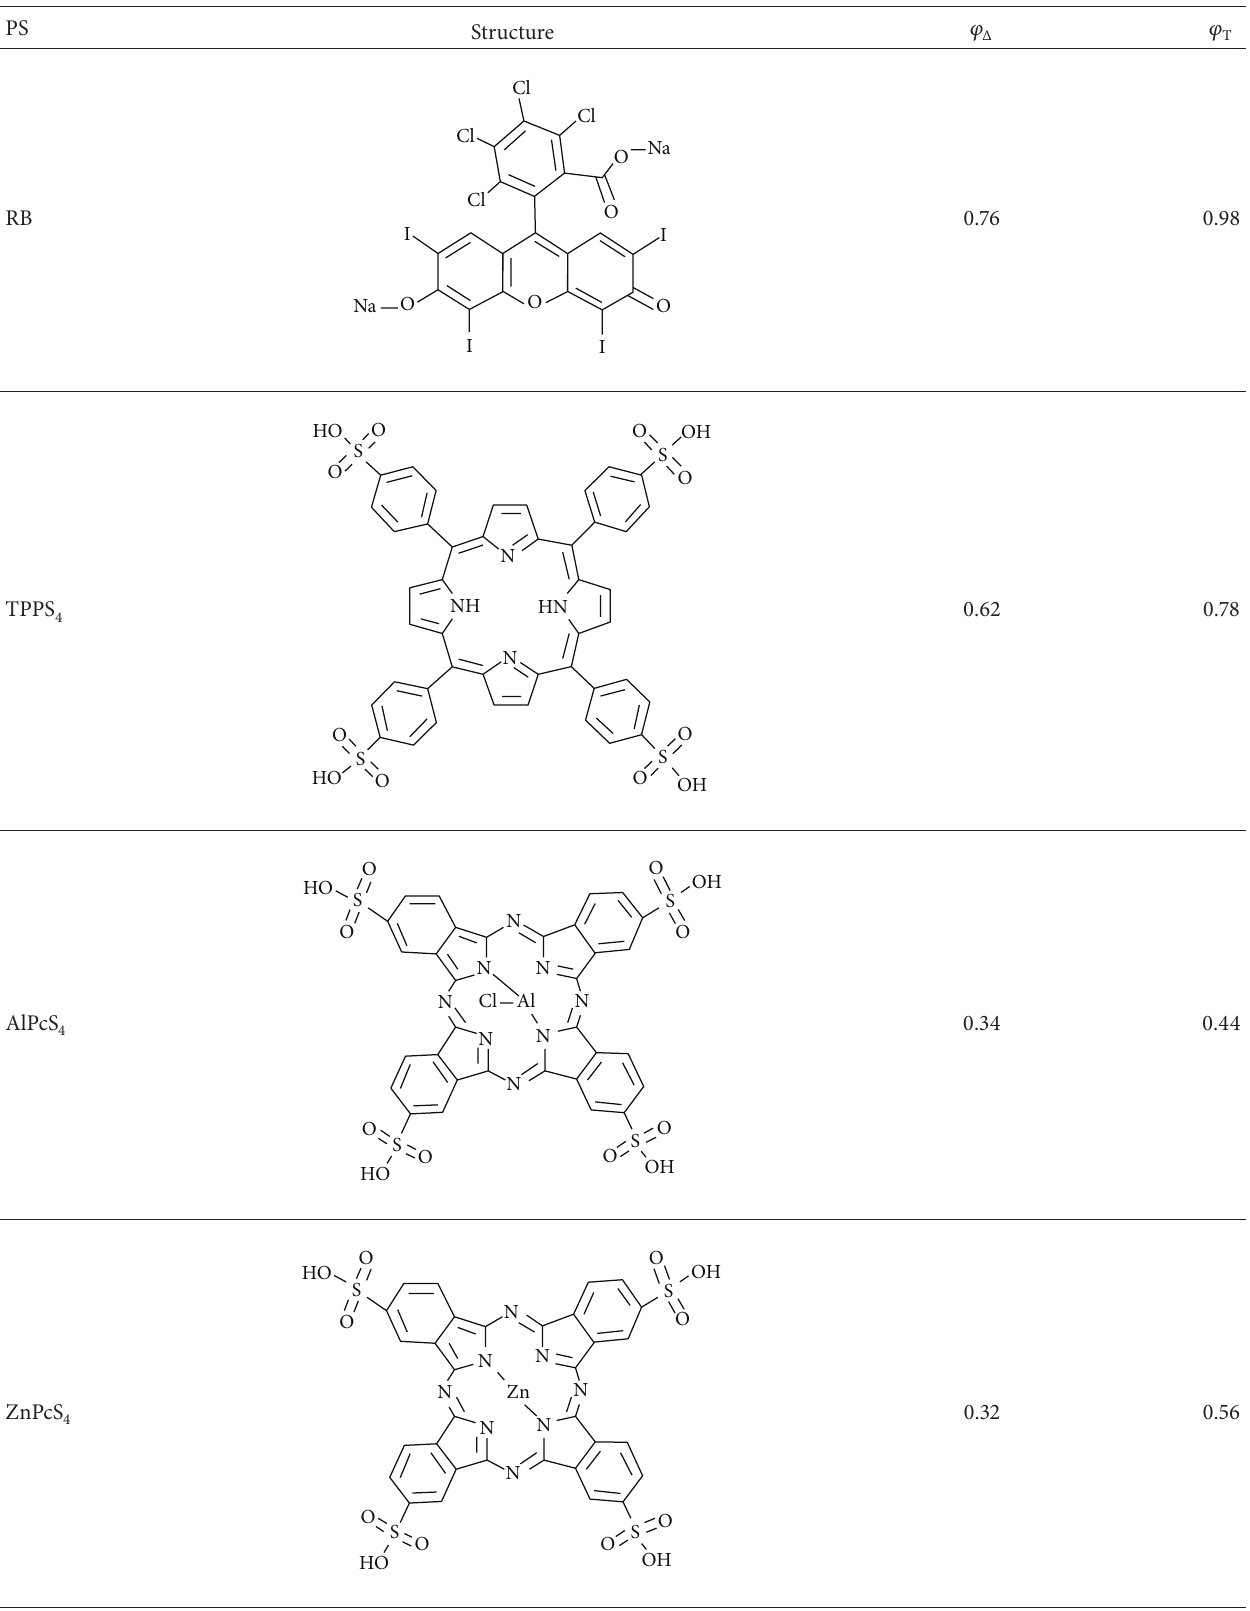
Table 1: The physicochemical properties of the dyes used in experiments